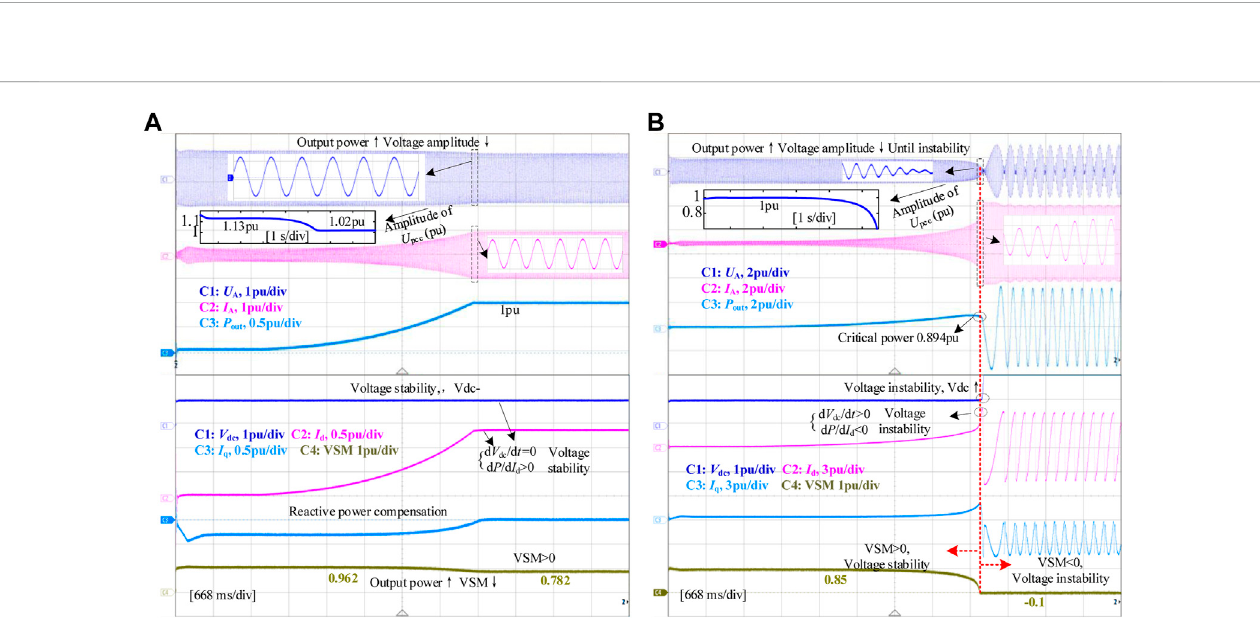
FIGURE 14 Comparison of VSM under different output reactive power. (A) I q = 0.2pu, (B) I q = −